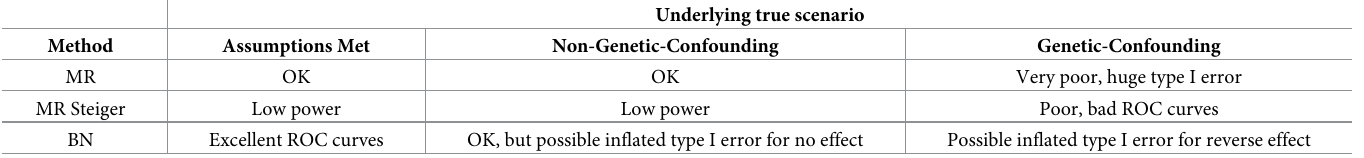
Table 2. Performance of MR, MR Steiger and BN on the simulated quantitative trait